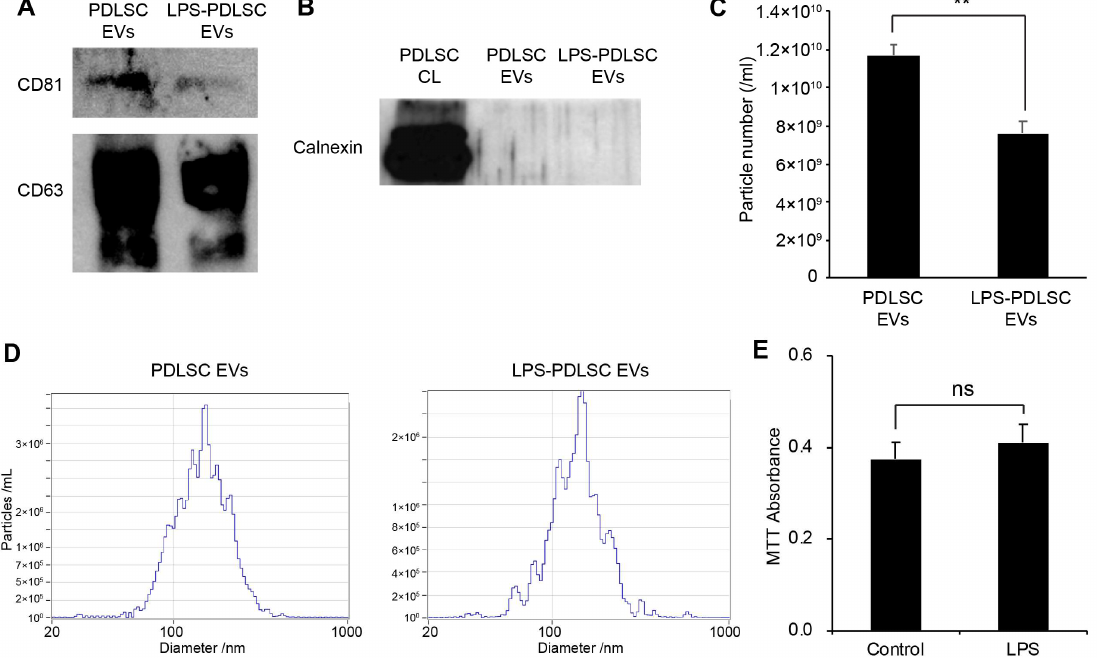
Figure 6. Isolation of EVs from PDLSCs and their characterization. EVs were isolated from PDLSCs by differential centrifugation, as described in the Materials and Methods section. The EVs were analyzed by western blot and nano-particle tracking analyzer, Zetaview. ( A ) Western blot analysis of isolated EVs for the EV markers, CD81, and CD63. ( B ) Western blot analysis of the PDLSC cell lysates and isolated EVs, for the endoplasmic reticulum marker, calnexin. ( C , D ). Analysis of particle number and size for each EV sample by Zetaview. ( C ) Particle number of each isolated EV sample. Data shown as the mean ± SD, n = 3, ** p < 0.01. ( D ) Particle size distribution for each EV sample. ( E ) Cell viability for PDLSCs with or without LPS treatment. Data are shown as the mean ± SD, n = 5, ns: Not significant.